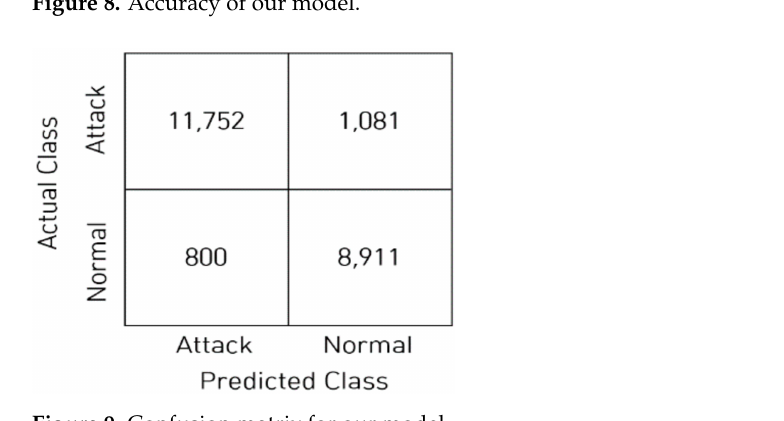
Figure 8. Accuracy of our model.